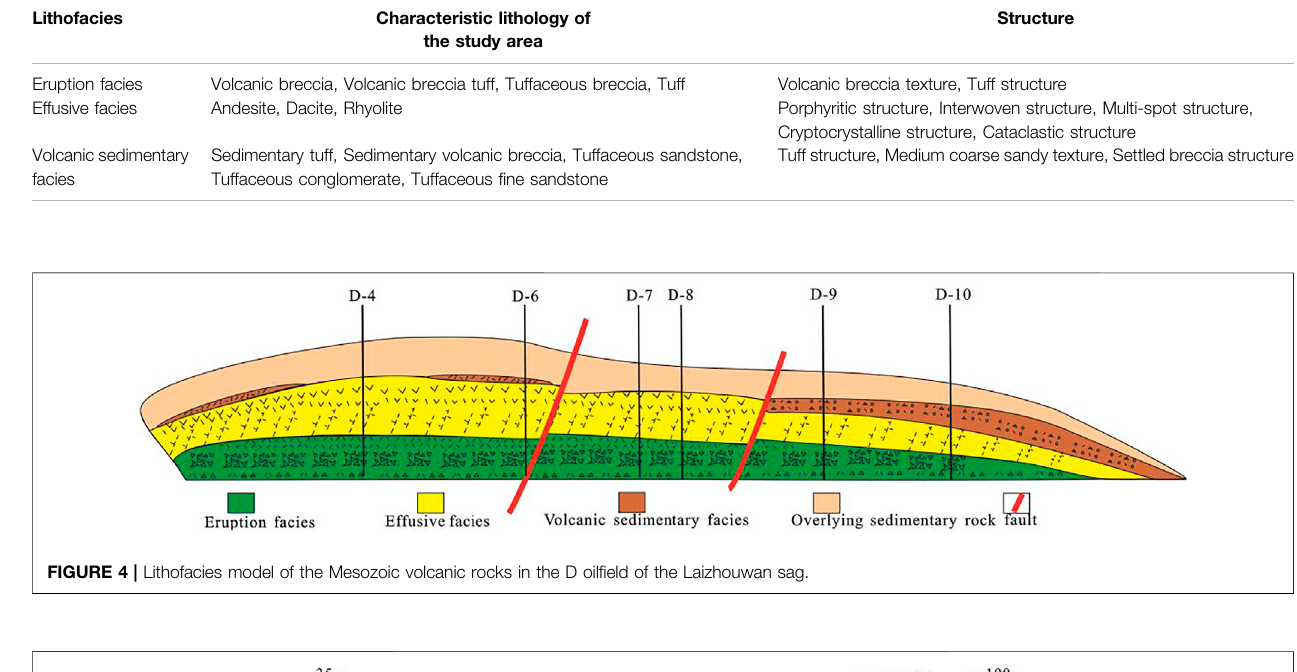
Frontiers in Earth Science |